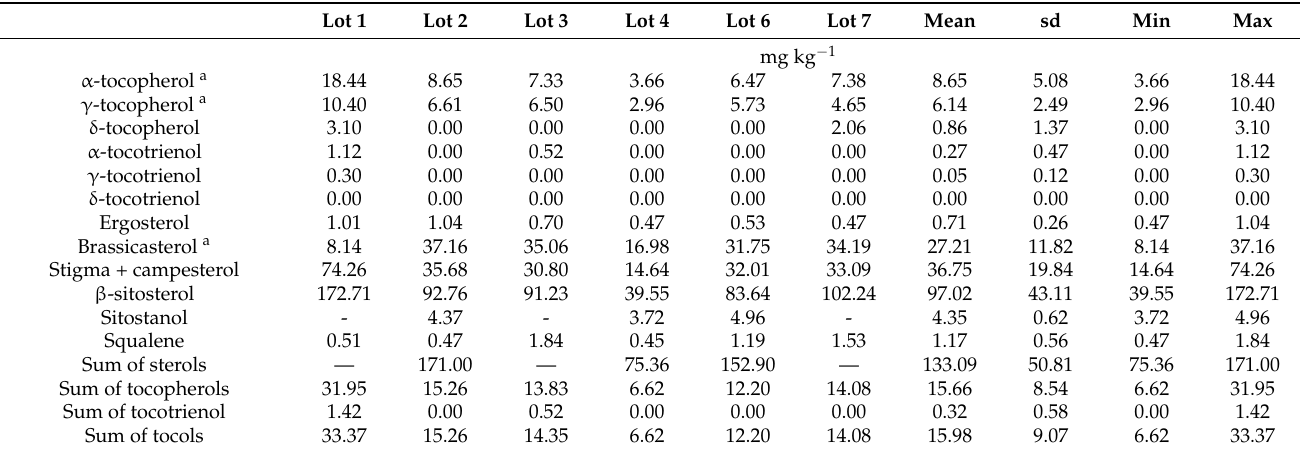
* data for each lot represent the mean of triplicate measurements. Details on the origin of rapeseed meal and on lot sampling are provided in Section 3 and in Table S1. - data not available, — not applicable. a impure, coelution of an unidentified substance, as evidenced by the UV